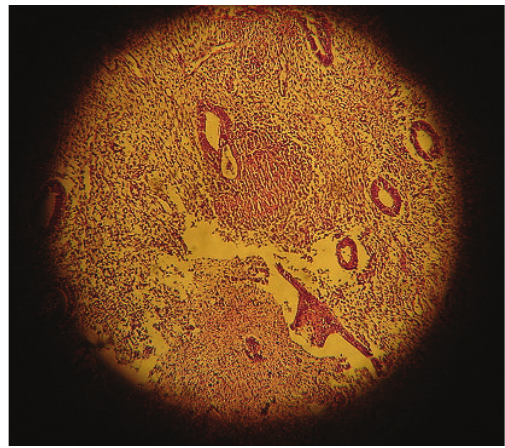
Figure 2: A classical tuberculosus granuloma formed by epithelioid macrophages, cu ff ed by lymhocytes and containing a Langhans gi- ant cell (H&E ×